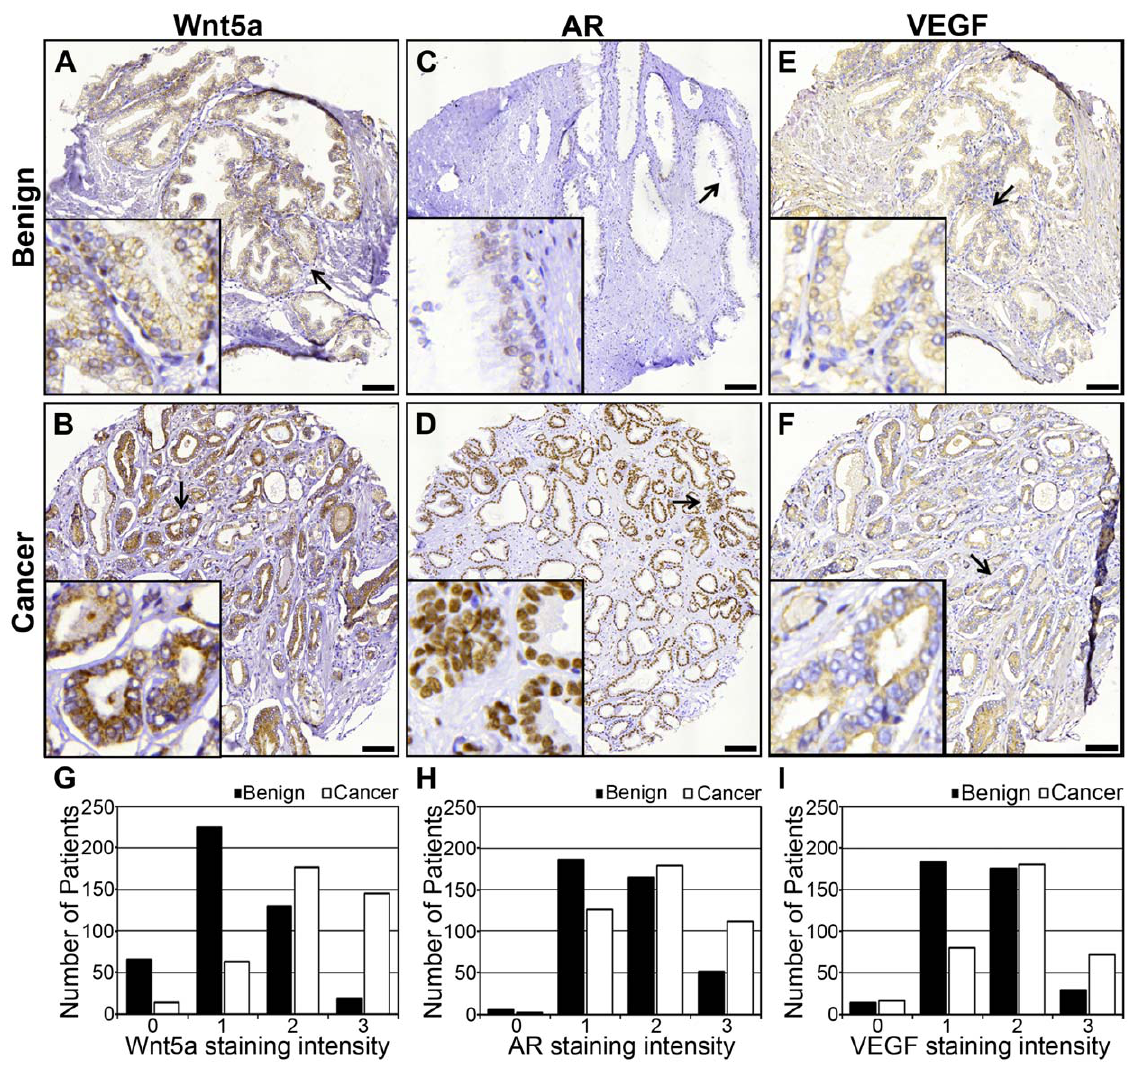
Figure 1. Immunohistochemical expression of Wnt5a, AR and VEGF in tissue microarray cores of primary tumors and benign specimens obtained after radical prostatectomy. A & B ) The panels show representative Wnt5a immunostainings in benign and cancer tissue areas from the same patient C & D ) The panels show representative nuclear AR immunostainings in benign and cancer tissue areas E & F ) The panels outline VEGF immunostaining in benign and cancer tissue areas from the same patient. All inserts in the panels depict magnification (40 6 ) images of the area indicated by the arrow in the larger image seen at 15 6 magnification. G, H & I ) The panels outline graphical illustrations of Wnt5a, AR and VEGF protein expressions in benign and cancer samples in PCa patients. The bar in each panel outlines 100 m